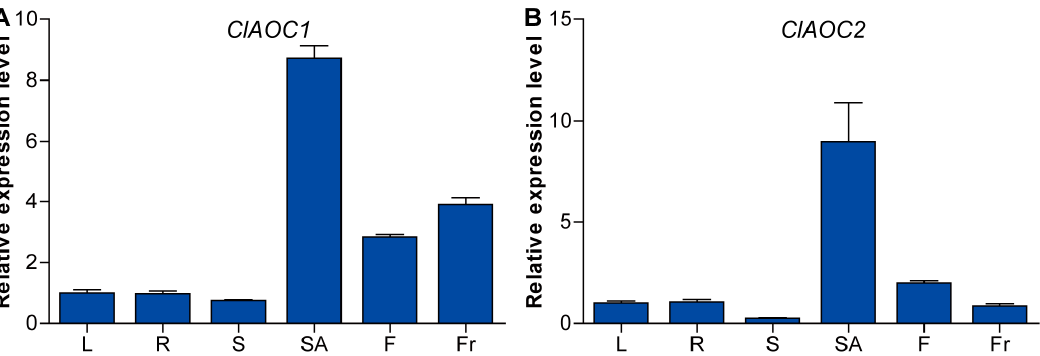
Figure 5. Relative mRNA levels of ClAOC1 ( A ) and ClAOC2 ( B ) determined by qRT-PCR in different tissues of watermelon. The β -actin gene was used as the internal control to standardize for each reaction. L, leaf; R, root; S, stem; SA, stem apex; F, flower; Fr, fruit. Agriculture 2019 , 9 , x FOR PEER REVIEW